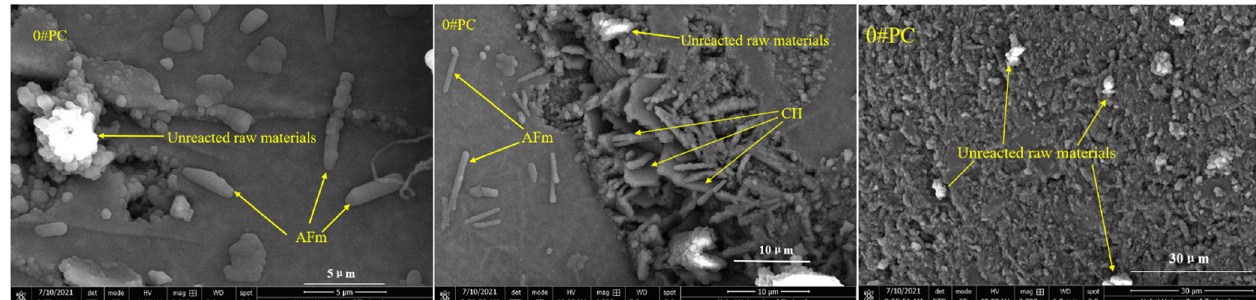
Figure 11. SEM images for 0#PC; ( a ), ( b ) and ( c ) are SEM images of 0#PC.